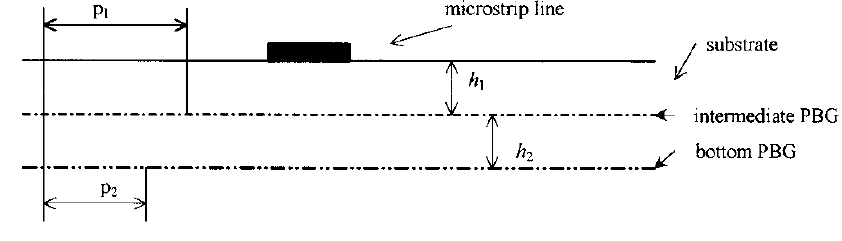
FIGURE 1 Schematic view of the cross-section of the LPF